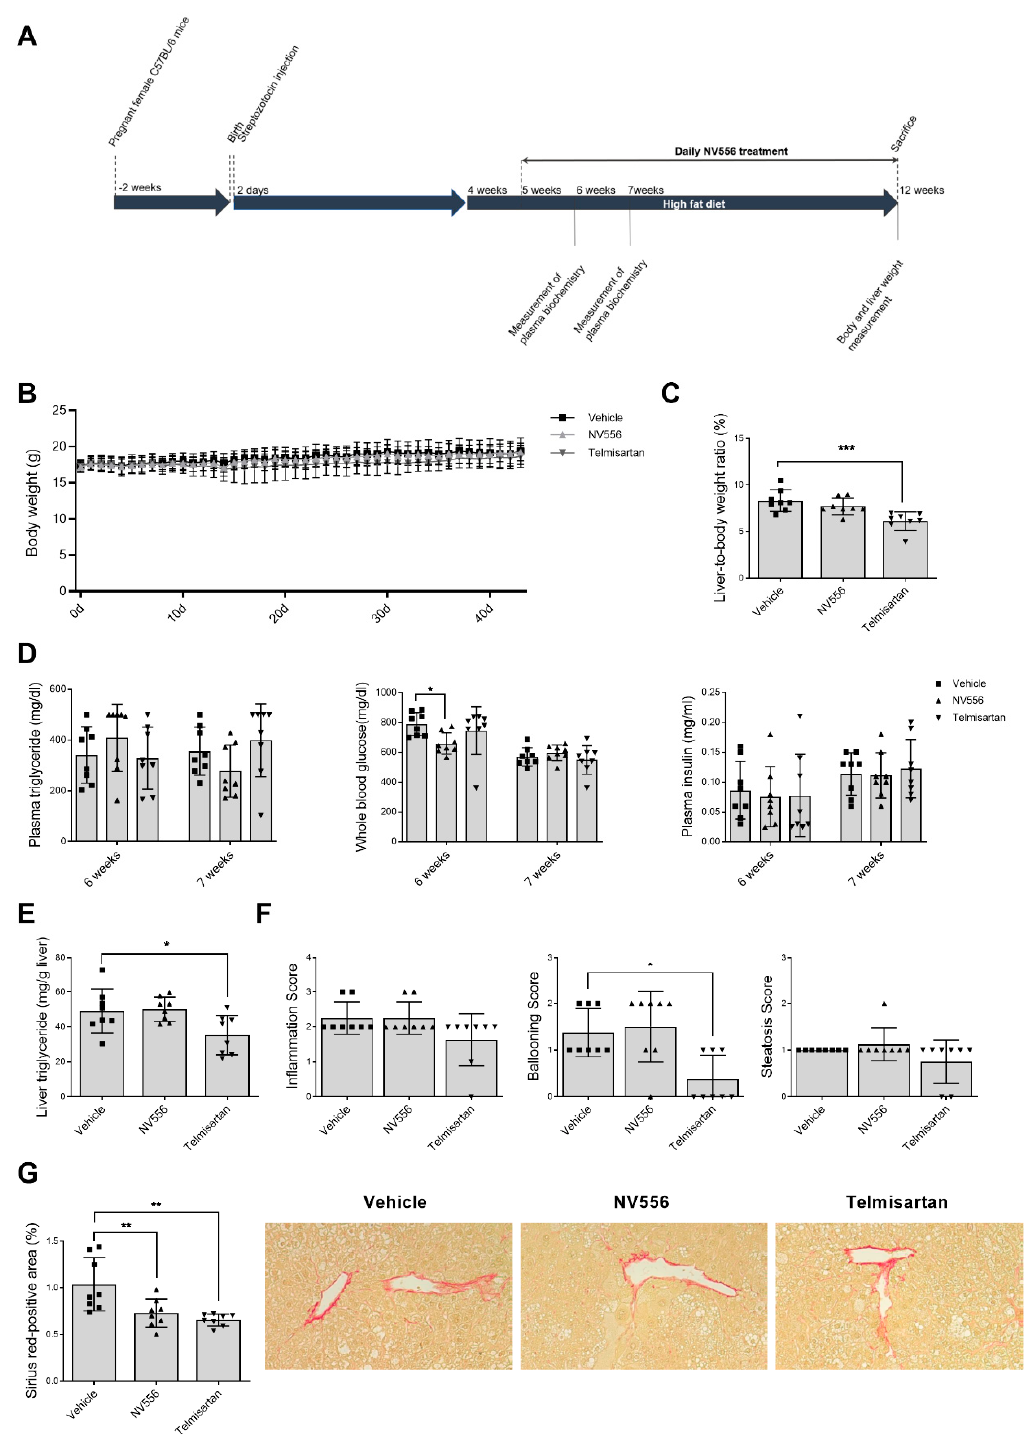
Figure 2. E ff ect of NV556 treatment in the STAM model of nonalcoholic steatohepatitis ( A ) Experimental timeline and parameters measured: ( B ) body weight and ( C ) liver / body-weight ratio, ( D ) plasma triglyceride, whole blood glucose, plasma insulin, ( E ) liver triglyceride, and ( F ) NAFLD scoring: inflammation, ballooning, and steatosis score ( G ) fibrosis area: representative photomicrographs at 200 × and values of Sirius-red positive areas. Data are represented as mean ± SD and statistically analyzed by one-way ANOVA, followed by Dunnett’s multiple comparison test for C, D, E, and G. F was statistically analyzed by Kruskal–Wallis, followed by Dunn’s multiple comparison test * p < 0.05, ** p < 0.01, *** p < 0.001, n = 8 mice per